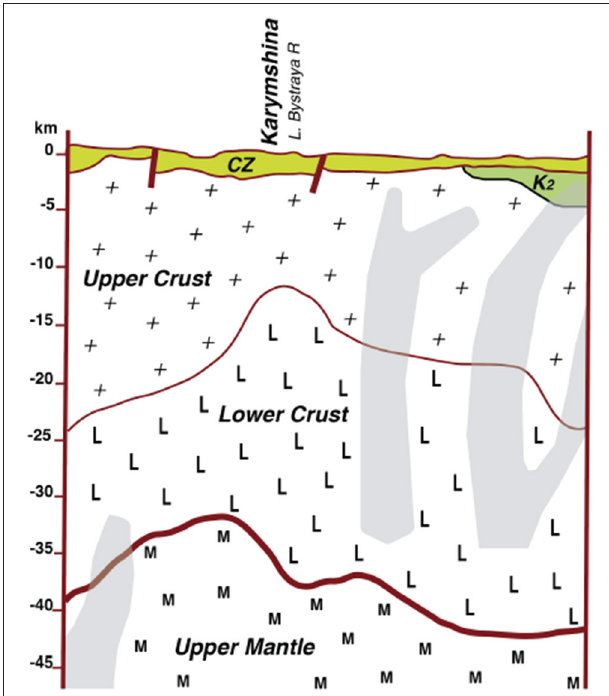
FIGURE 3 | Seismic profile across Karymshina caldera (Geological Map of the Russian Federation, 2000) showing regional 38–40km thick continental crust and crustal structure. Notice thinned upper crust and locally thickened lower crust under Karymshina that we interpret here as representing basaltic sills that were added to the upper crust causing its partial melting and progressive substitution with more mafic residue and basaltic cumulate in the process of magmatic evolution of Karymshina Volcanic Complex. CZ is Cenozoic volcanic and volcaniclastic cover, K 2 is Upper Cretaceous crust. Vertical gray areas represent faults according to magnetotelluric seismic